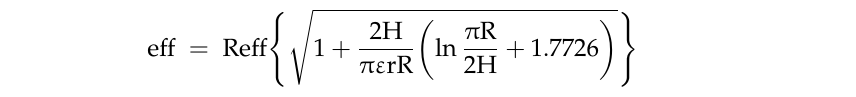
Figure 1. Proposed broadband antenna configuration ( a ) top-view ( b ) side-view. The effective radius (Reff) of the conventional circular-shaped radiator can be esti- mated by using the following relation